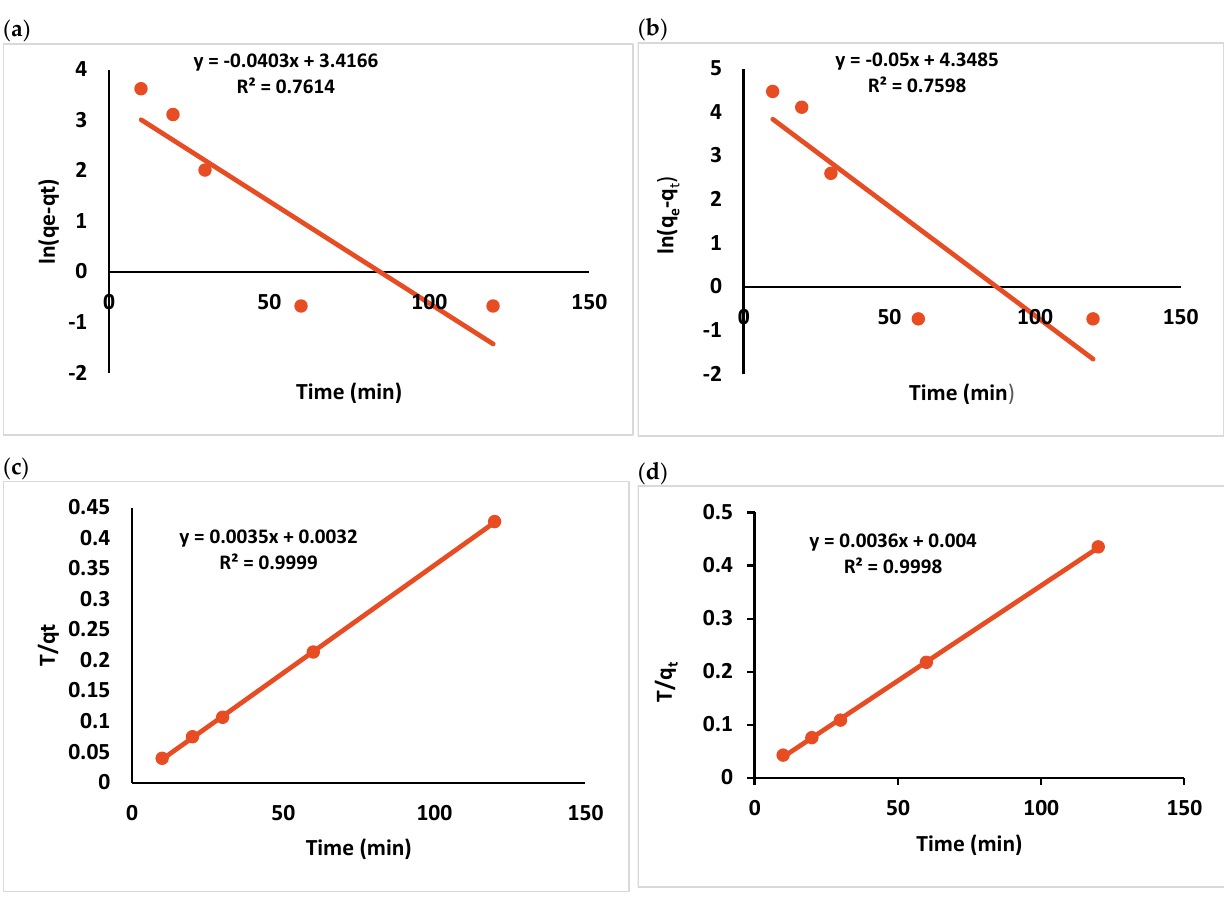
Figure 10. Pseudo-first order for Pb and Cr ( a , b ), pseudo-second order for Pb and Cr ( c , d ). Table 2. Adsorption kinetics parameters for metals adsorption on